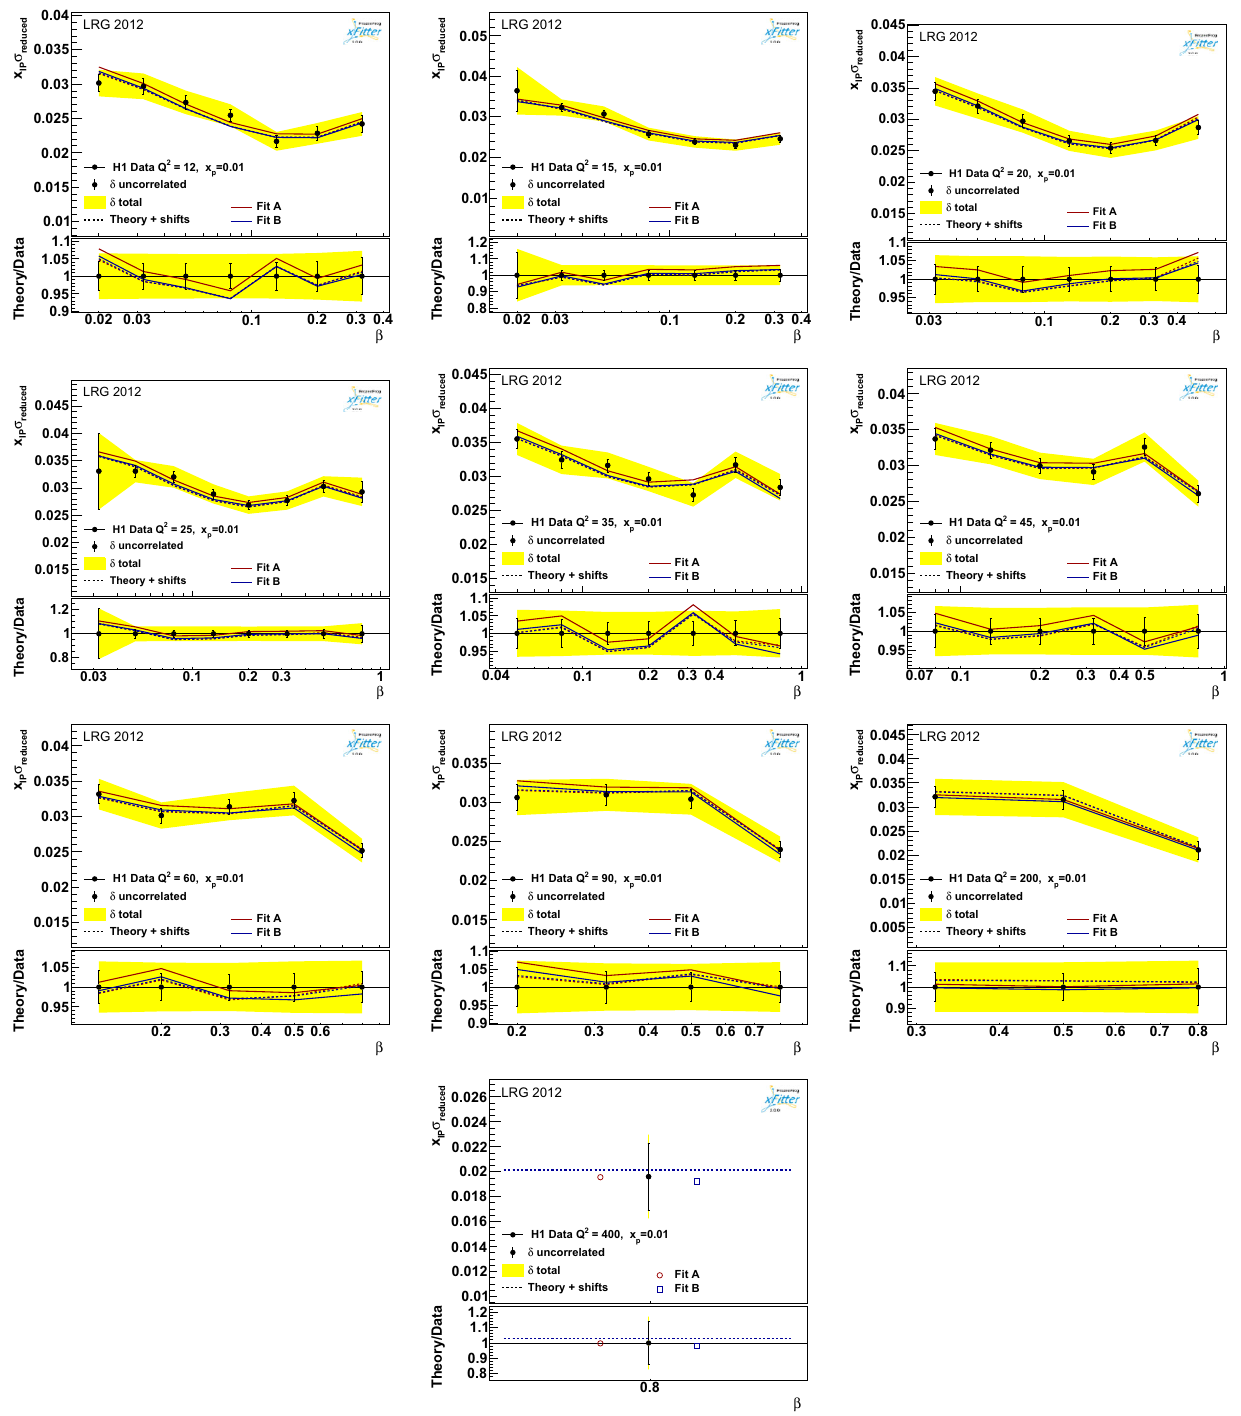
( 3 ) β for x = 0 . 01 in IP r as a function of In the case of H1-LRG-2011 data [42,43], we present in Fig. 14 the NLO pQCD fits of both our Fit A and Fit B . This figure shows, for instance, the NLO theory predic- ( 3 ) tions for the reduced diffractive cross section x IP σ D r as